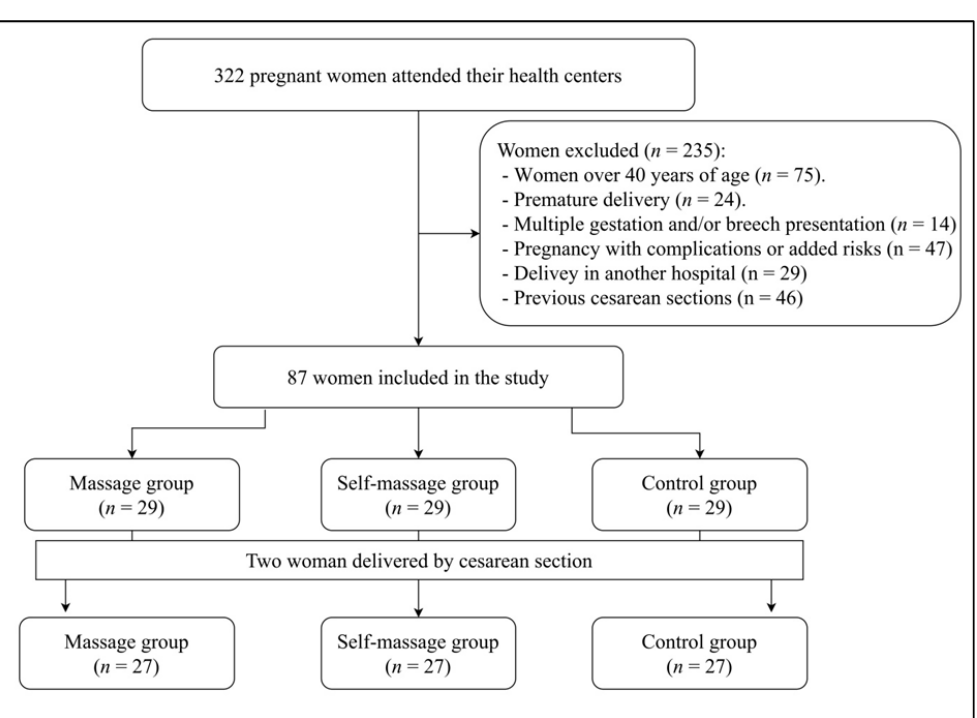
Figure 1. CONSORT flow